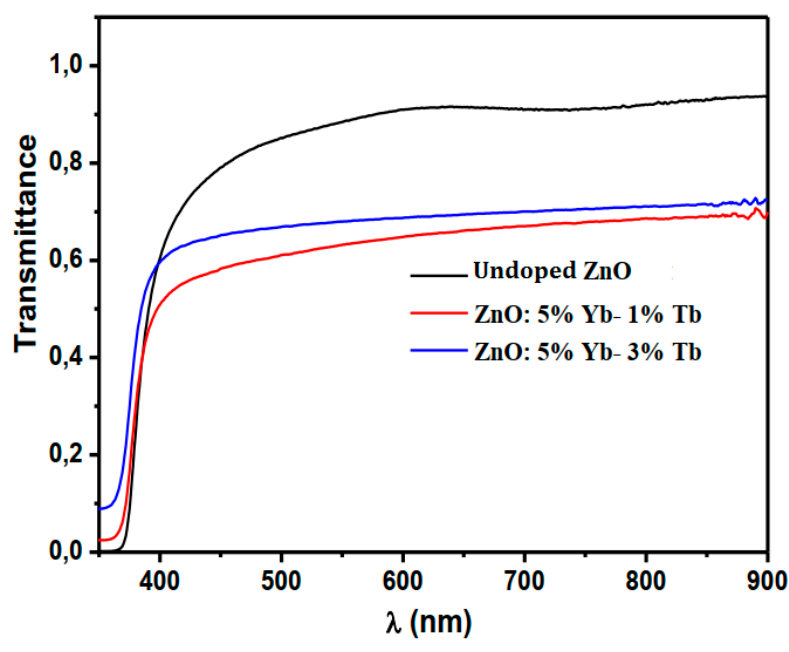
Figure 4. Optical transmittance as a function of wavelength for the same co-doped samples.